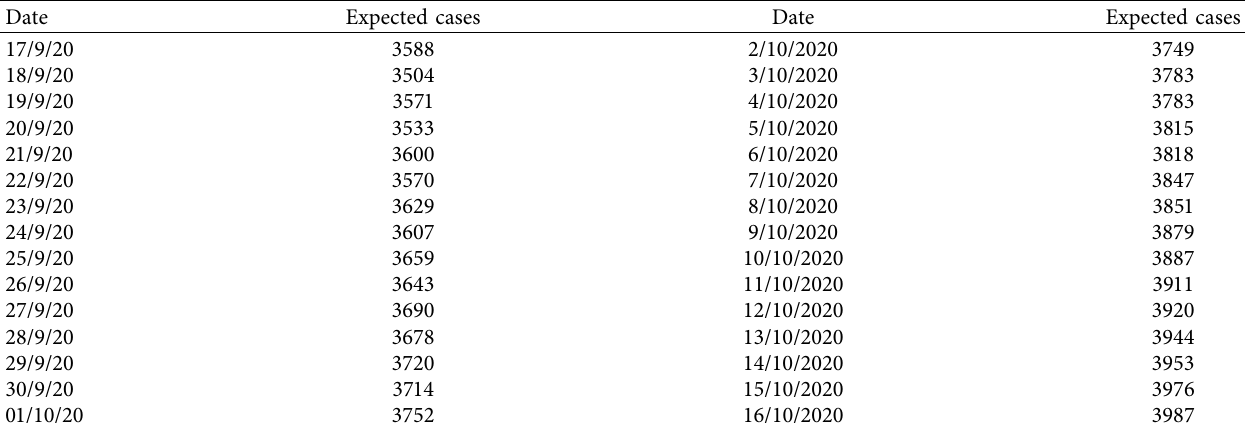
Table 5: The prediction results of daily confirmed new COVID-19 cases in North Africa for the next month as predicted by the ARIMA (1, 1, 4)